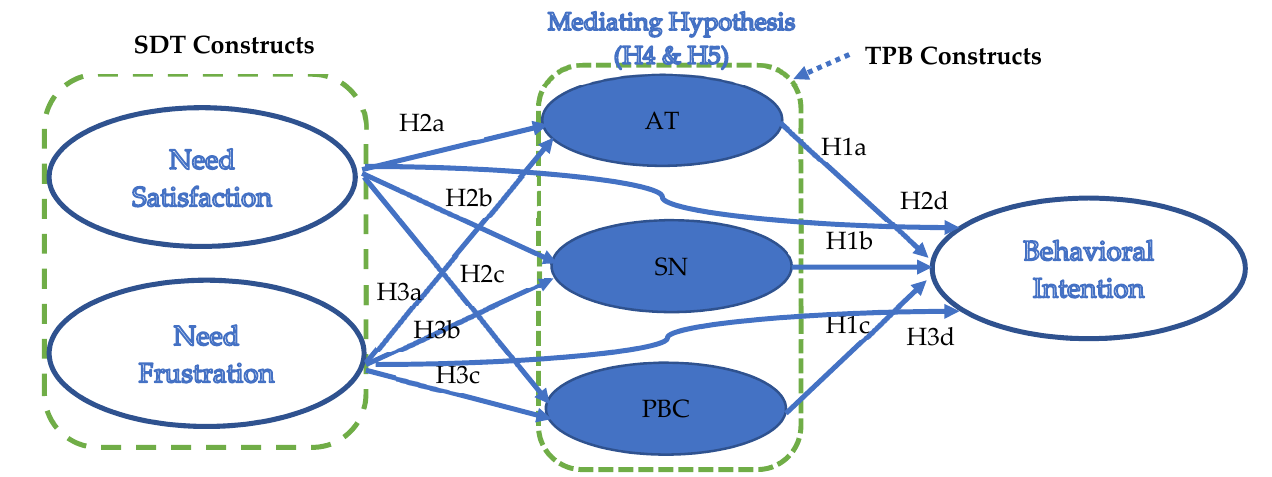
Figure 1. Proposed theoretical framework.